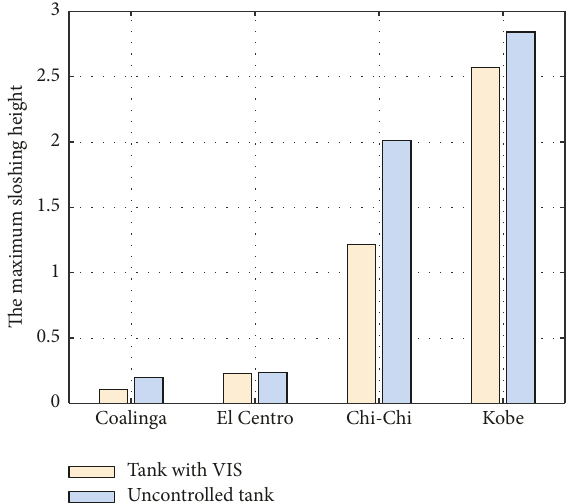
Figure 13: Maximum sloshing heights of the liquid in the tanks under different ground motions.